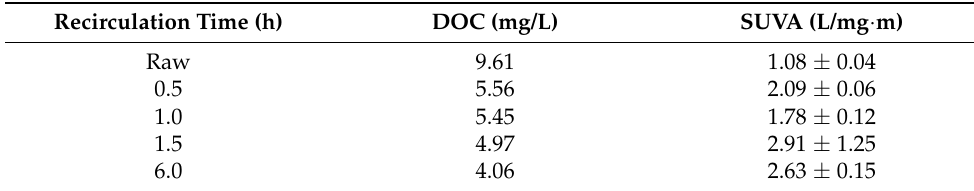
Table 2. SUVA values in system S1 during